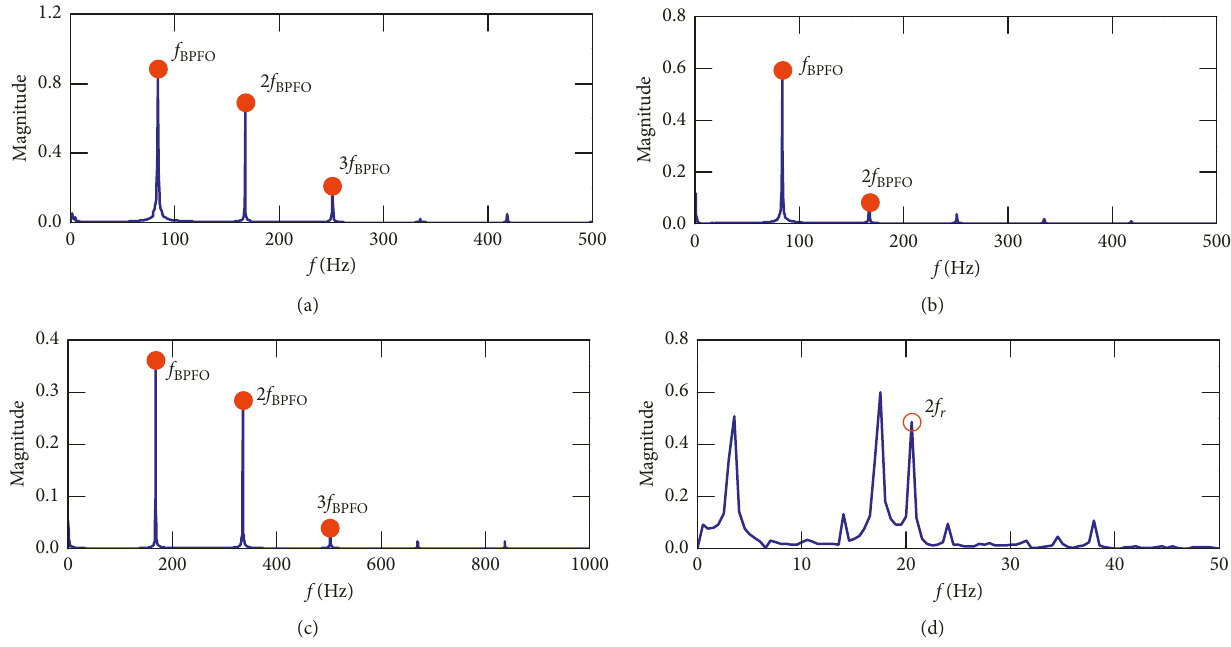
Figure 21: Results obtained by Hankel-SVD for a bearing compound fault signal: (a–d) envelope spectra of IMF 1, IMF 2, IMF 3, and IMF 4,